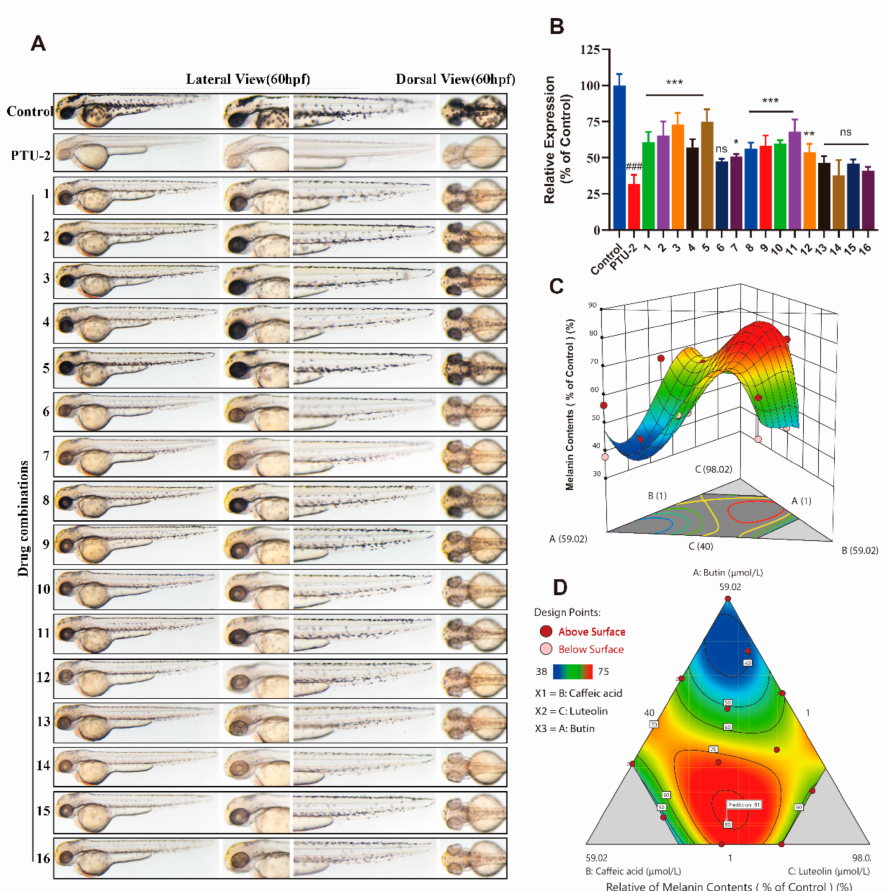
Figure 9. The inducing melanogenesis activity and combinational design of components, and response surface methodology and contour plots of melanogenesis effect for component combinations. ( A ) Zebrafish melanin phenotype in each combination group. ( B ) The relative of melanin contents (% of control), results shown are mean ± SEM. Data were analyzed by ANOVA followed by post hoc Tukey test. n = 30 zebrafish, ### p < 0.001 vs. control, ns, non-significant, *** p < 0.001, ** p < 0.01, * p < 0.05 vs. PTU-2. ( C ) 3D response surface of the relative of melanin contents (% of control). ( D ) The results of this figure were predicted by the data reported in Table